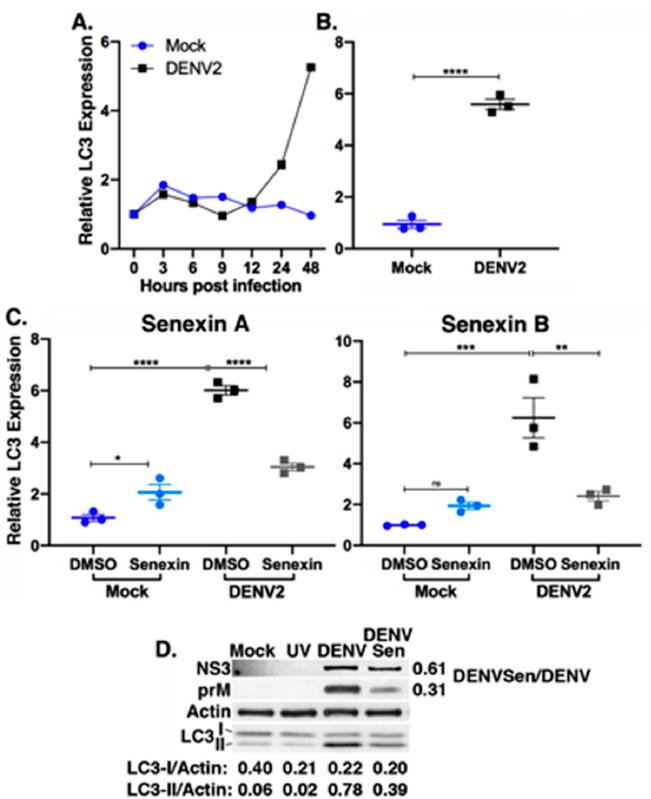
Figure 5. Senexin A reduces DENV2 induction of lipophagic gene expression. ( A ) Huh7 cells were either mock-infected or infected with DENV at MOI 10, and LC3 mRNA expression analyzed by qRT-PCR at indicated time points. Expression relative to time of infection, normalized to SDHA and representative of two independent time course experiments. ( B ) LC3 expression in mock vs. infected cells at 48 hpi ( n = 3 biological replicates; *** p < 0.001 unpaired, two-tailed t test with Welch’s correction). Error bars represent mean +/ − SEM. ( C ) LC3 mRNA expression in Huh7 cells